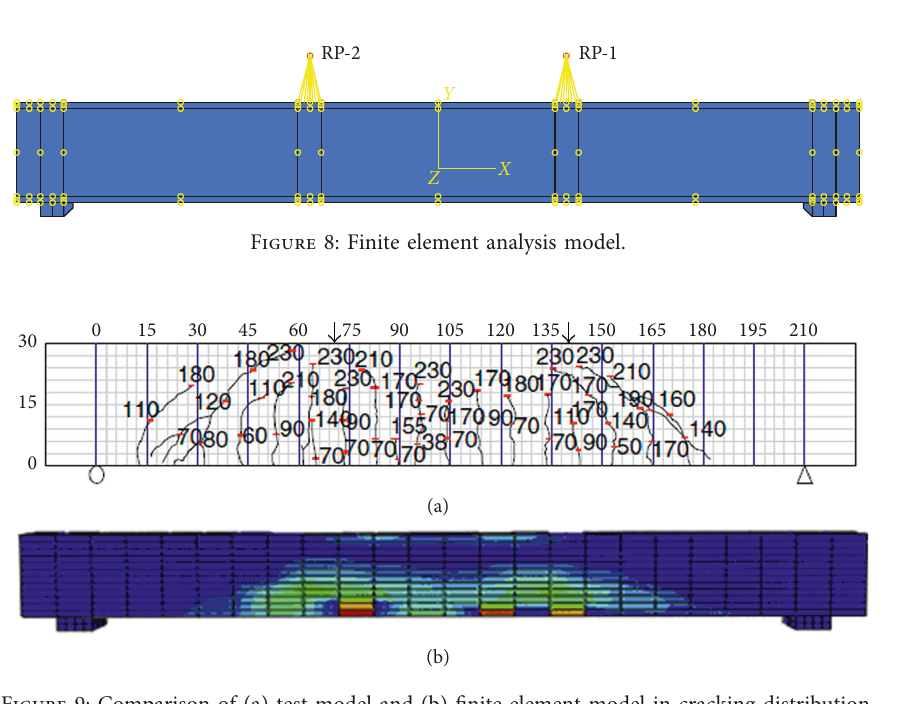
Figure 9: Comparison of (a) test model and (b) finite element model in cracking distribution.